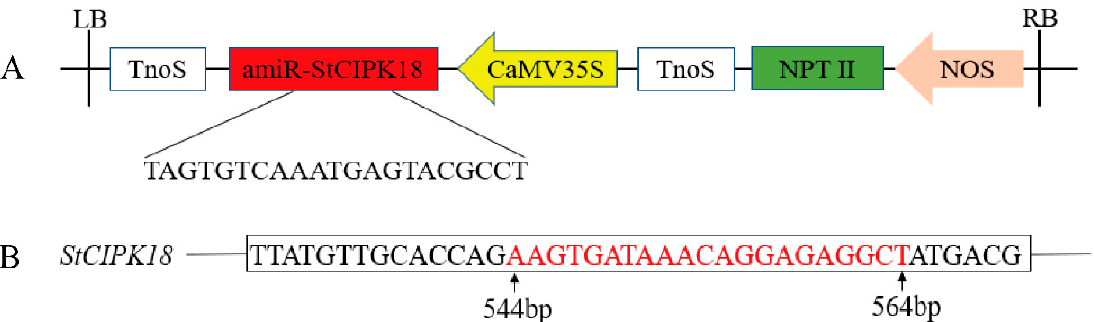
Figure 7. RNAi-mediated gene silence in transgenic potato plants. ( A ) Schematic illustration of the engineered pCPB121-StCIPK18 vector. ( B ) Schematic illustration of the target region of the StCIPK18 gene.